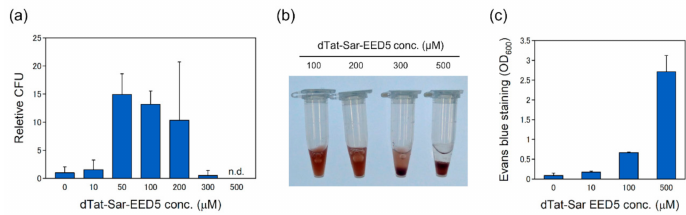
Figure 3. E ff ects of dTat-Sar-EED5 on R. sulfidophilum cells. ( a ) The pDNA delivery e ffi ciency at di ff erent concentrations of dTat-Sar-EED5. The data were normalized by ‘0 µ M dTat-Sar-EED5 (cid:48) . n.d., not detected. ( b ) E ff ects of dTat-Sar-EED5 on R. sulfidophilum cell cultures. Photos were taken just after the dTat-Sar-EED5 treatment. ( c ) Evans blue staining of R. sulfidophilum cells after the dTat-Sar-EED5 treatment. Data are the mean ± SD of at least three